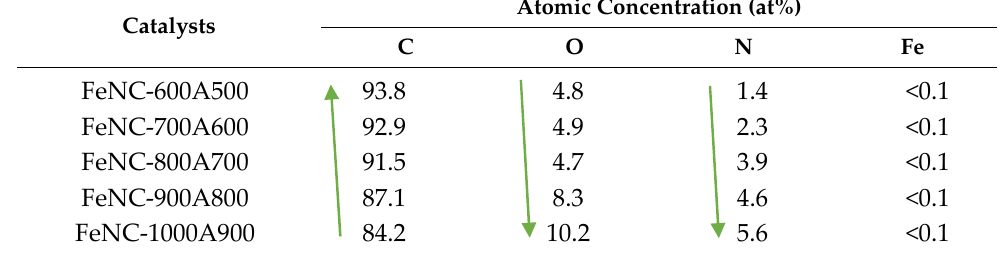
Table 2. Compositions of various –Ns of FeNCs determined by XPS